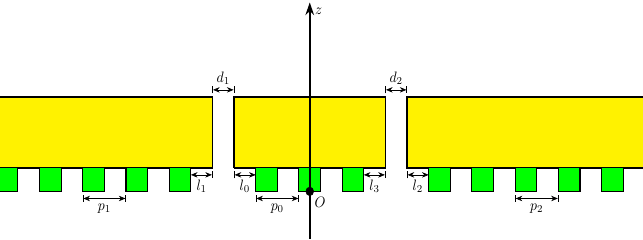
Figure 2. Schematic of the two-slit beaming structure to be optimized. In a Cartesian coordinate system with coordinate ( x , z ) , the structure’s bottom is located at z = 0, and the origin is at the center of the middle part of the